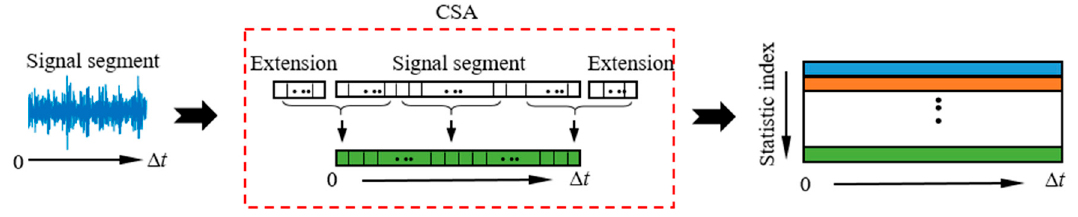
Figure 1. The process of continuous statistical analysis.